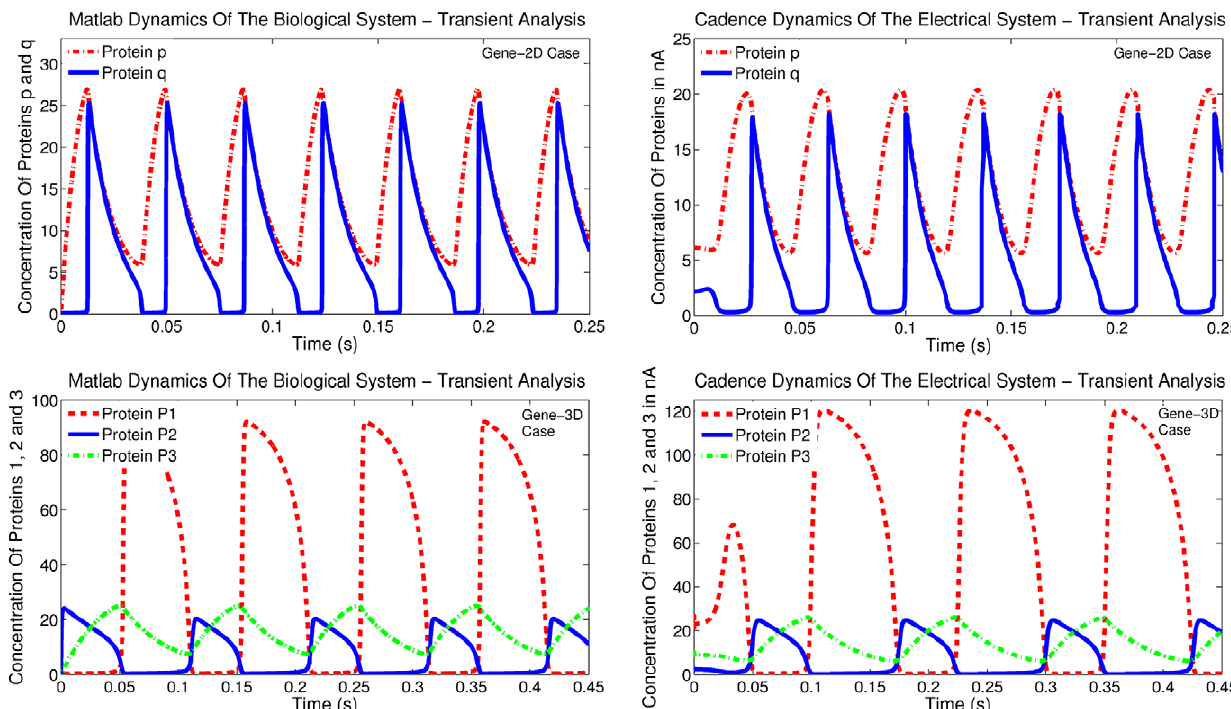
Figure 15. Comparison of transient analysis results generated by MATLAB (cid:2) and Cadence simulations for the gene-protein regulatory circuits.